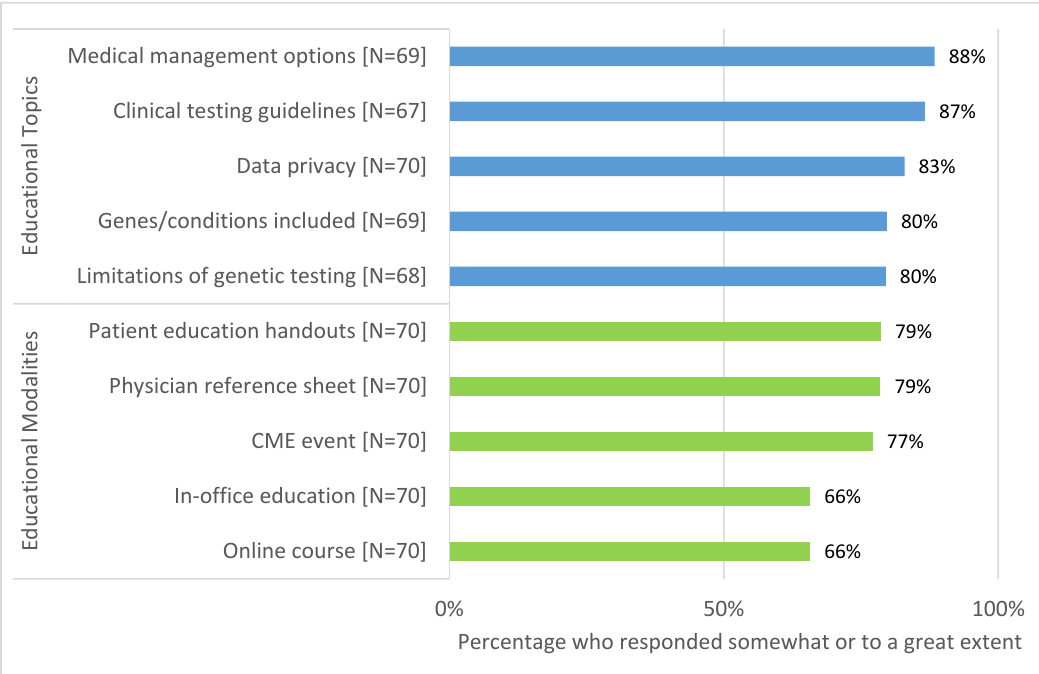
Figure 2. Requested education topics and preferred modalities.